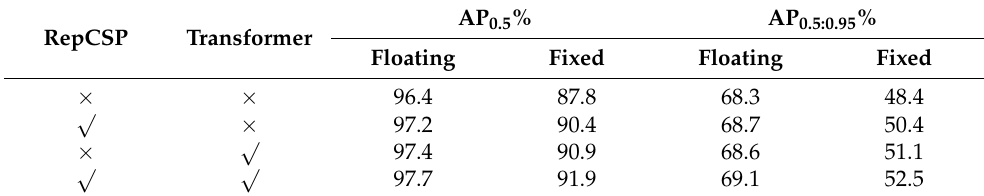
Table 2. Classification results of the ablation experiments.